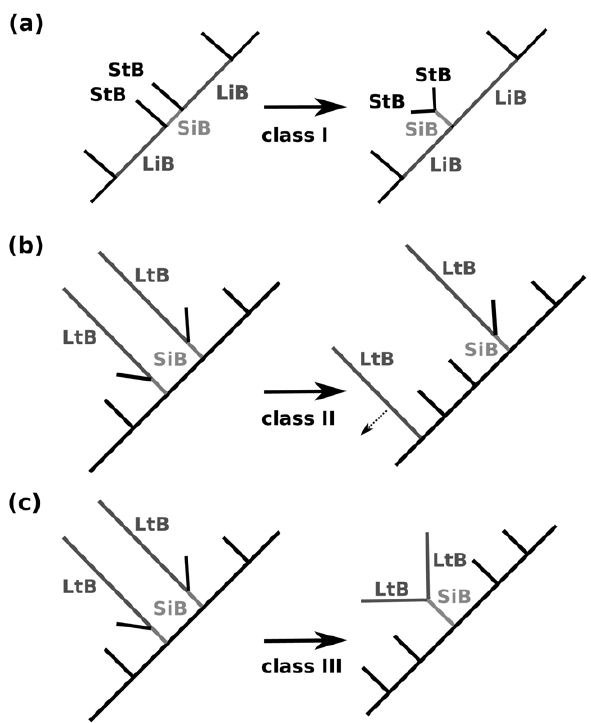
Figure 1. Long branch effects. (a) class I effect (attraction due to symplesiomorphies): two short terminal branches (StB), separated by a short internal branch (SiB) are grouped together due to true homologies. The true homologies are mainly produced by plesiomor- phies which can only be identified in rooted topologies. The rest of the tree is found at the ends of two long internal branches (LiB) on either side of the two short branches. (b) class II effect: At least one of the two long teminal branches (LtB) slides down the tree or appears elsewhere in the resulting tree topology, mainly due to signal erosion along the corresponding long terminal branch (c) class III effect: Two